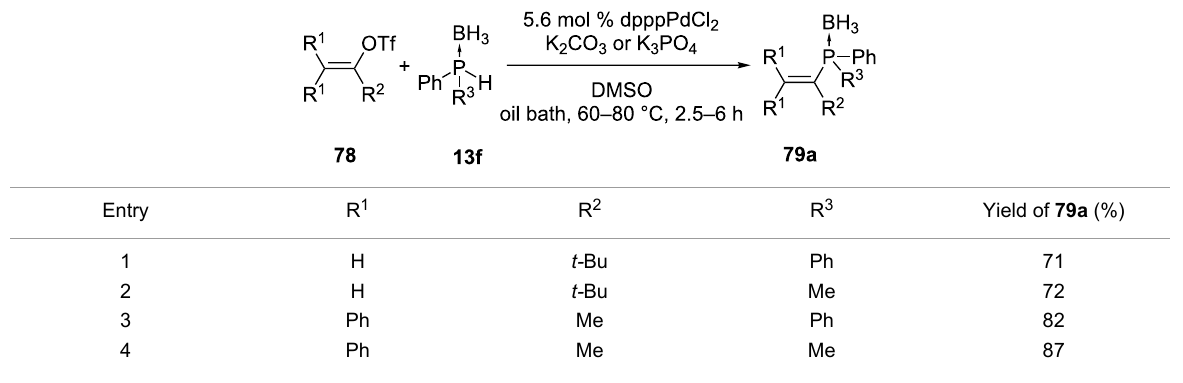
Table 7: Palladium-catalyzed C–P coupling between acyclic vinyl triflates and phosphine boranes (dppp =